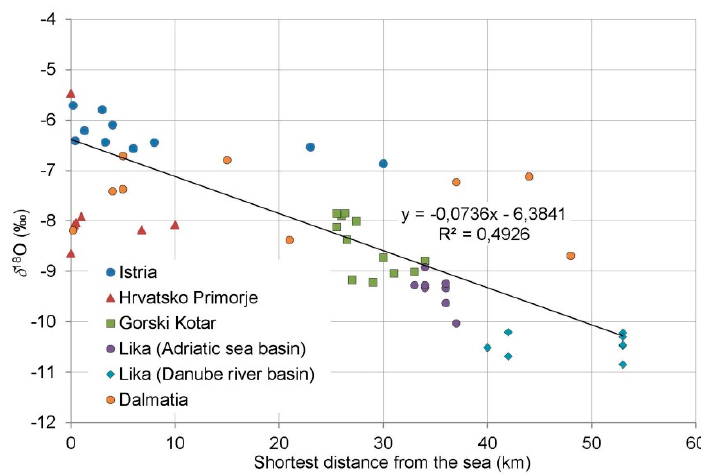
Figure 4. The mean δ 18 O vs. the shortest distance from the sea. 346